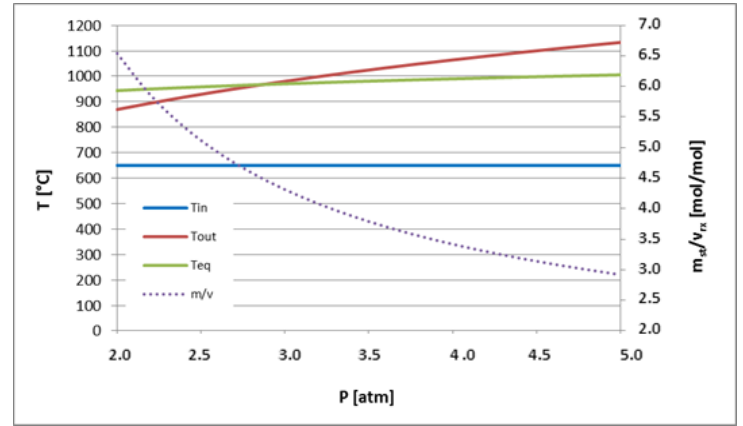
Figure 14 . Mn 2 O 3– Mn 3 O 4 system (charging phase): parametric analysis of the reactor outlet temperature, reactor inlet flow, and reactor equilibrium temperature varying the inlet flow total pressure (assuming power block outlet pressure: 1 atm).